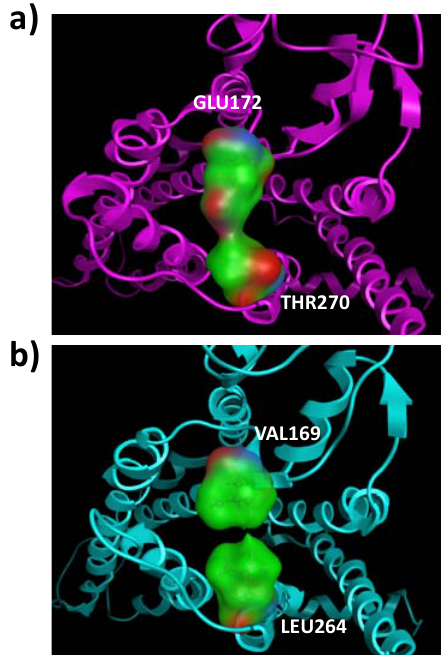
Figure 4. Molecular surface showing favored interaction areas generated in the ( a ) h A 1 and ( b ) h A 3 . Red color represents hydrogen-bond areas, green color shows hydrophobic areas, and blue represents mildly polar interfaces. Protein structures are viewed from the extracellular side.